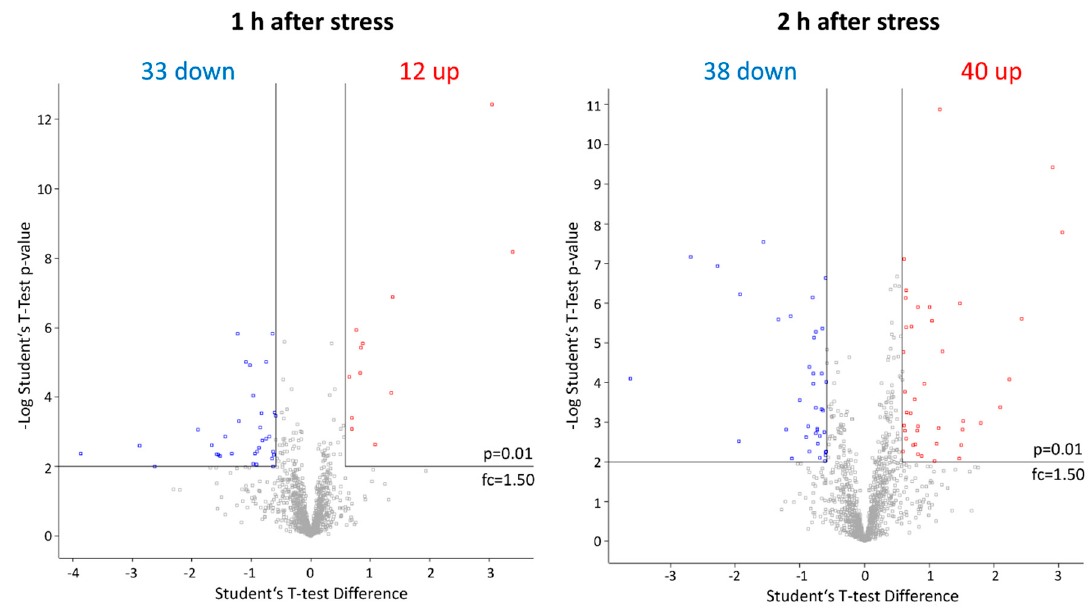
Figure 4. Graphical representation of significantly# affected proteins after LL-37 treatment via Volcano plots. Proteins with an increase in abundance after application of the stress are labeled in red and proteins with a decrease in protein abundance in blue, respectively. # Student’s t -test ( p -value= 0.01, min. fold change = 1.5).